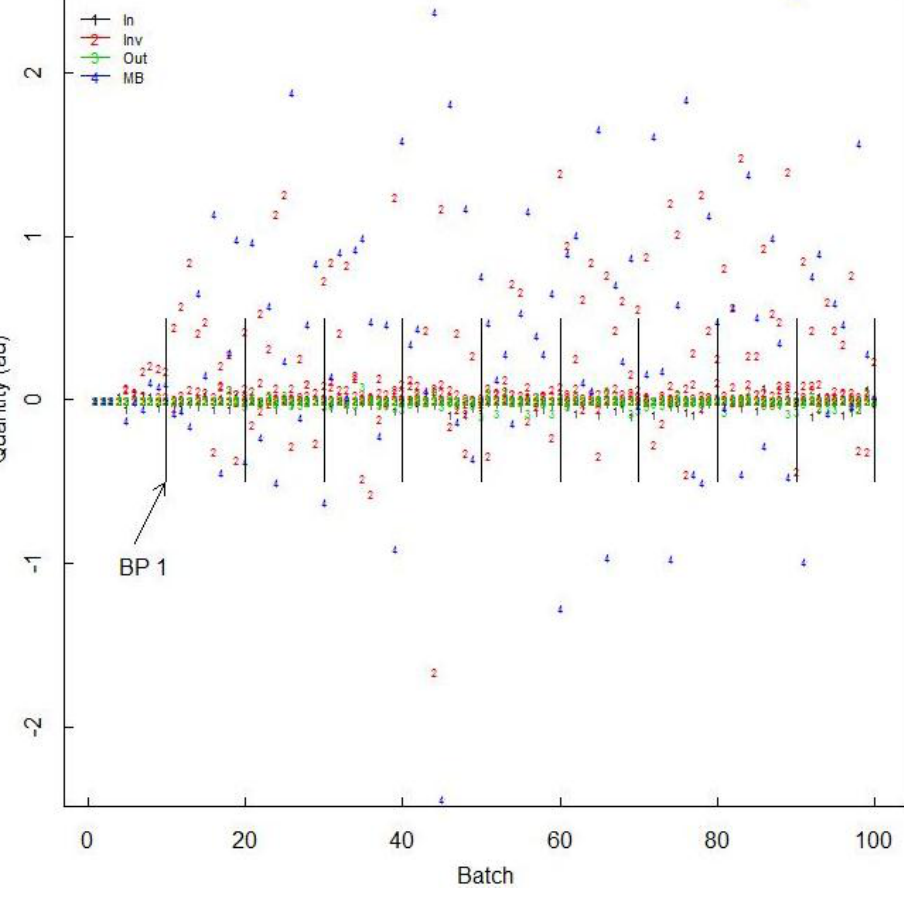
Figure 6. Daily residuals from the one input, from each of the eight inventory vessels, from each of the four output vessels, and the daily MB. We also consider less frequent BPs, every 10